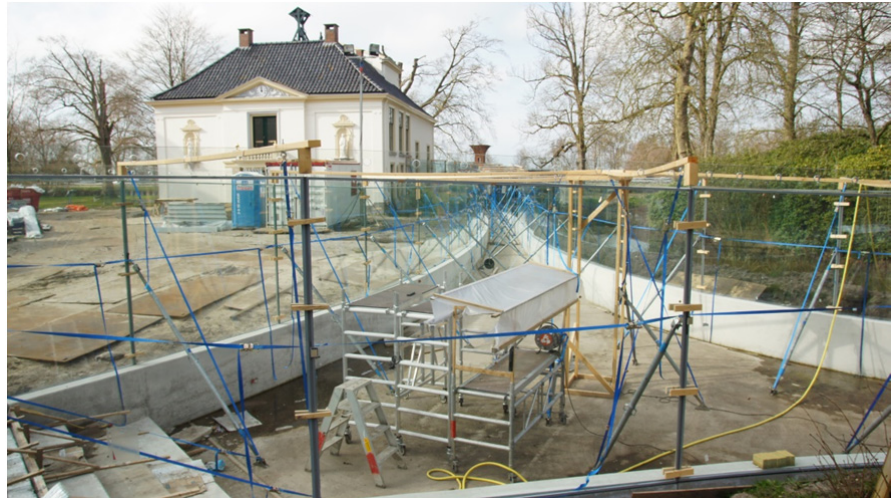
Fig. 14 The central hall of the pavilion under